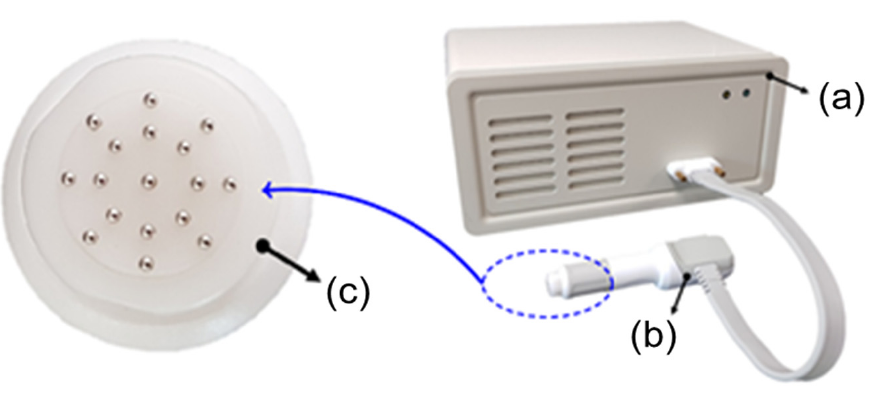
Figure 1. The system for screening of CIN using electrical bioimpedance spectroscopy-based multi- electrode probe: ( a ) bioimpedance spectroscopic measurement device, ( b ) multi-electrode probe, and ( c ) configuration of multiple pin electrodes used for the screening